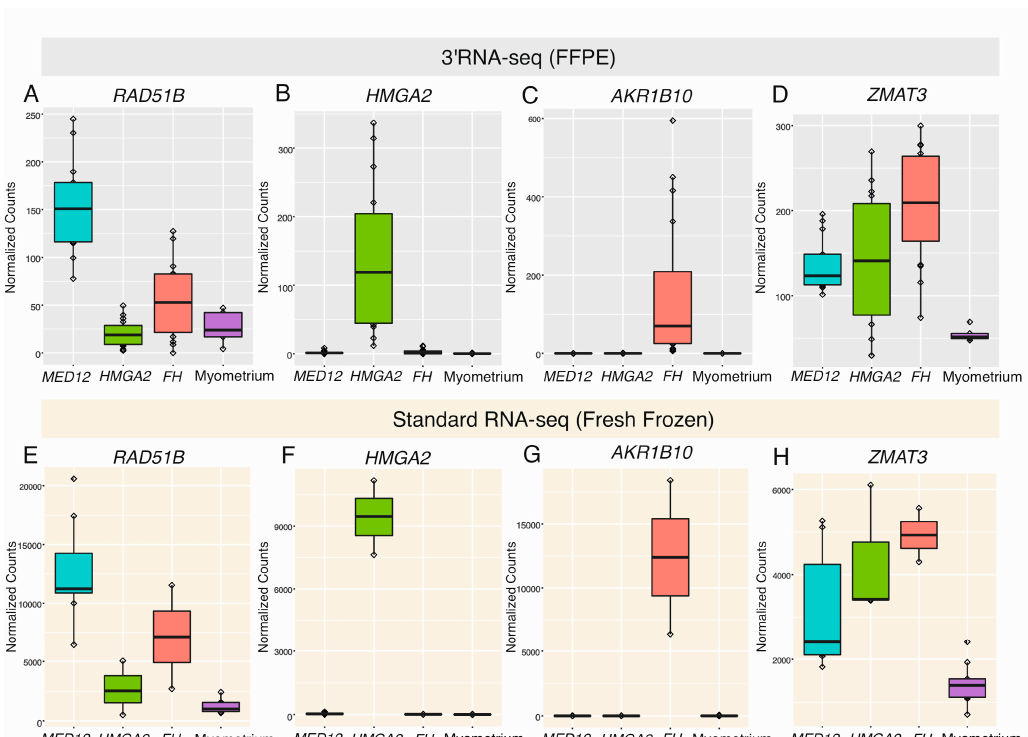
Figure 2. Highlighted genes previously shown to be dysregulated in leiomyomas. ( A ) Using 3 (cid:48) RNA sequencing of formalin-fixed para ffi n-embedded (FFPE) tissue, we confirmed significant upregulation of RAD51B in leiomyomas with a MED12 mutation. ( B ) We also confirmed significant upregulation of HMGA2 in leiomyomas displaying positive IHC staining for HMGA2 . ( C ) High expression levels of AKR1B10 were only seen in leiomyomas displaying positive IHC staining for 2SC. ( D ) Upregulation of ZMAT3 was seen in the majority of leiomyomas, regardless of subtype. ( E – H ) Similar observations were seen in an independent dataset of fresh frozen tissue that was sequenced using standard RNA